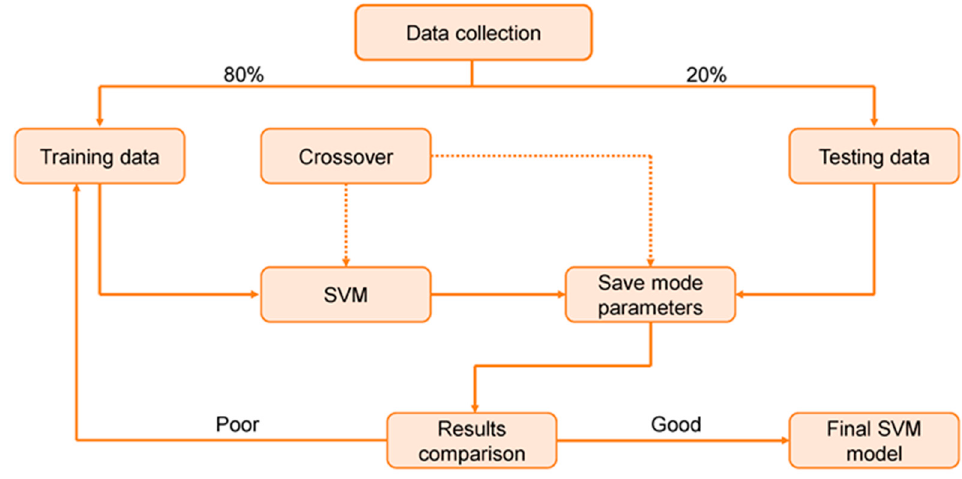
Figure 5. Execution process of the SVM model [65].